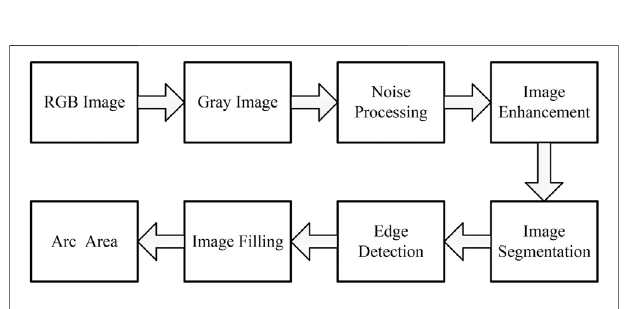
FIGURE 2 | Block diagram of image